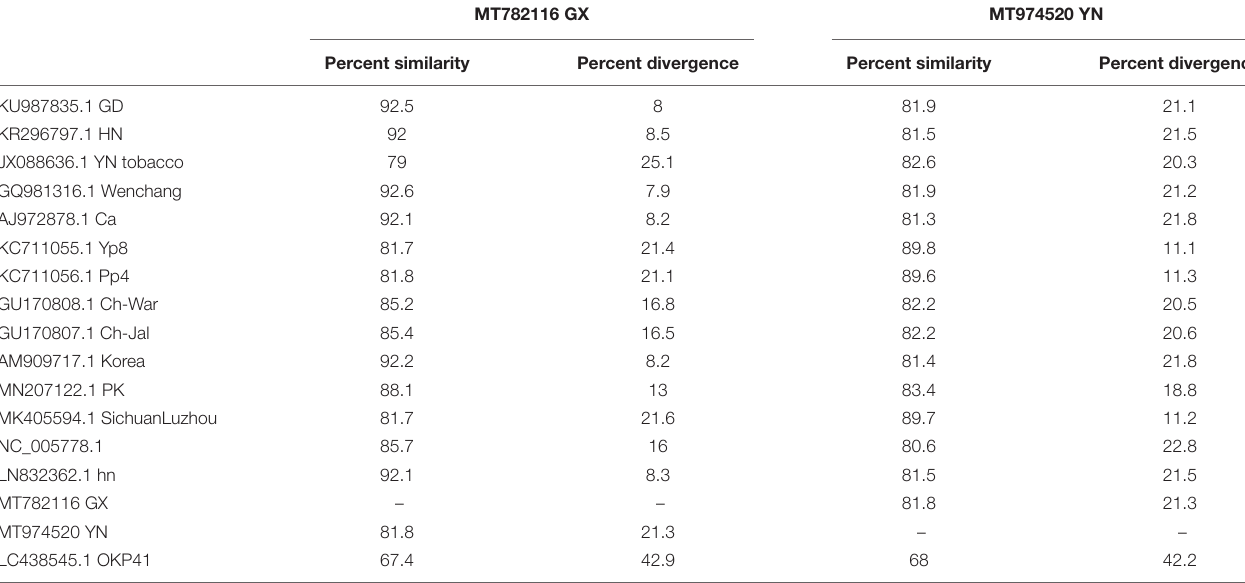
TABLE 1 | Nucleotide sequence similarity and divergence among the 16 ChiVMV isolates worldwide based on their full genome